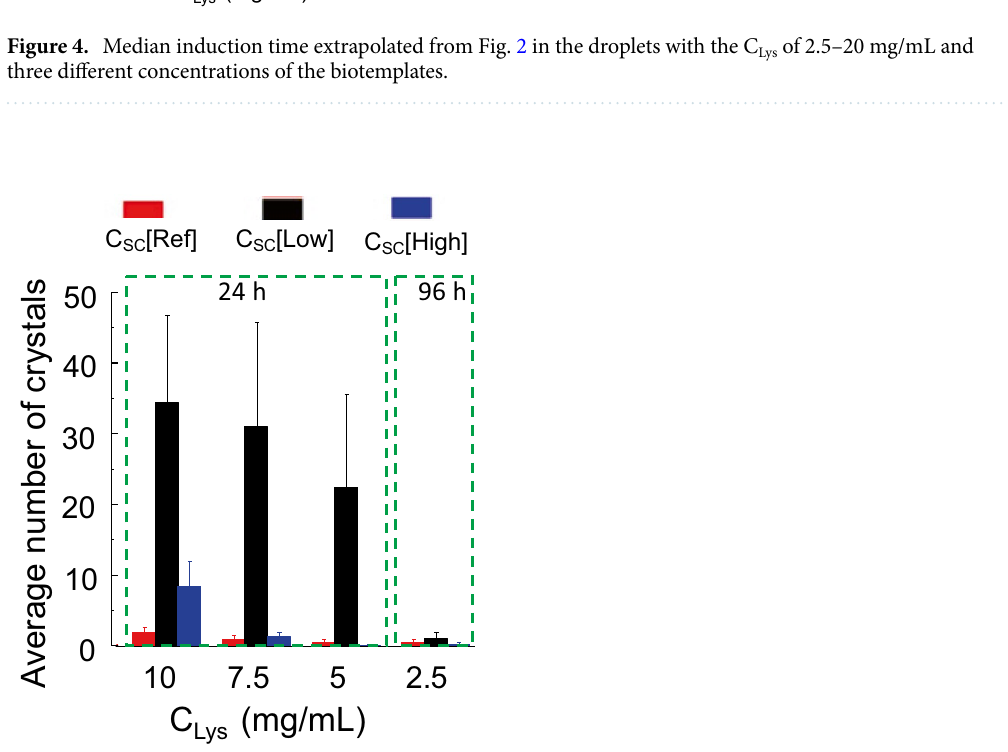
Figure 5. Average numbers of crystals obtained in each droplet at the C Lys of 10, 7.5 and 5 mg/mL at 24 h, and at C Lys of 2.5 mg/mL at 96